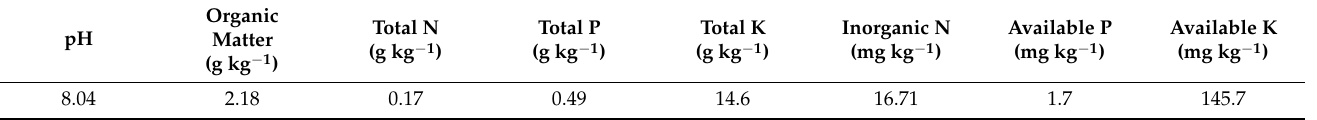
Table 1. Basic soil characteristics before the start of the experiment.